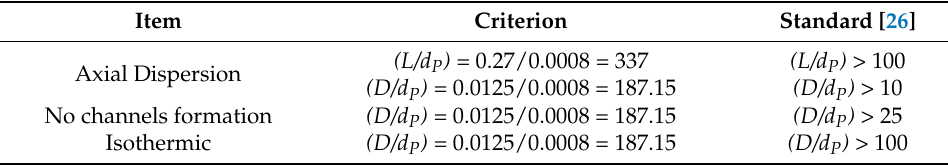
Table 2. Laboratory reactor compliance